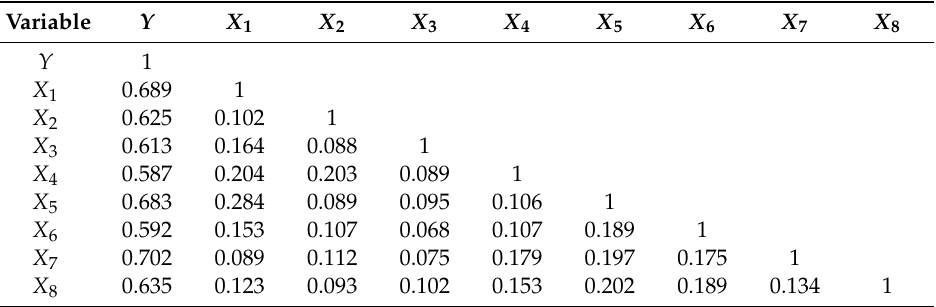
Table 4. The matrix of correlation.